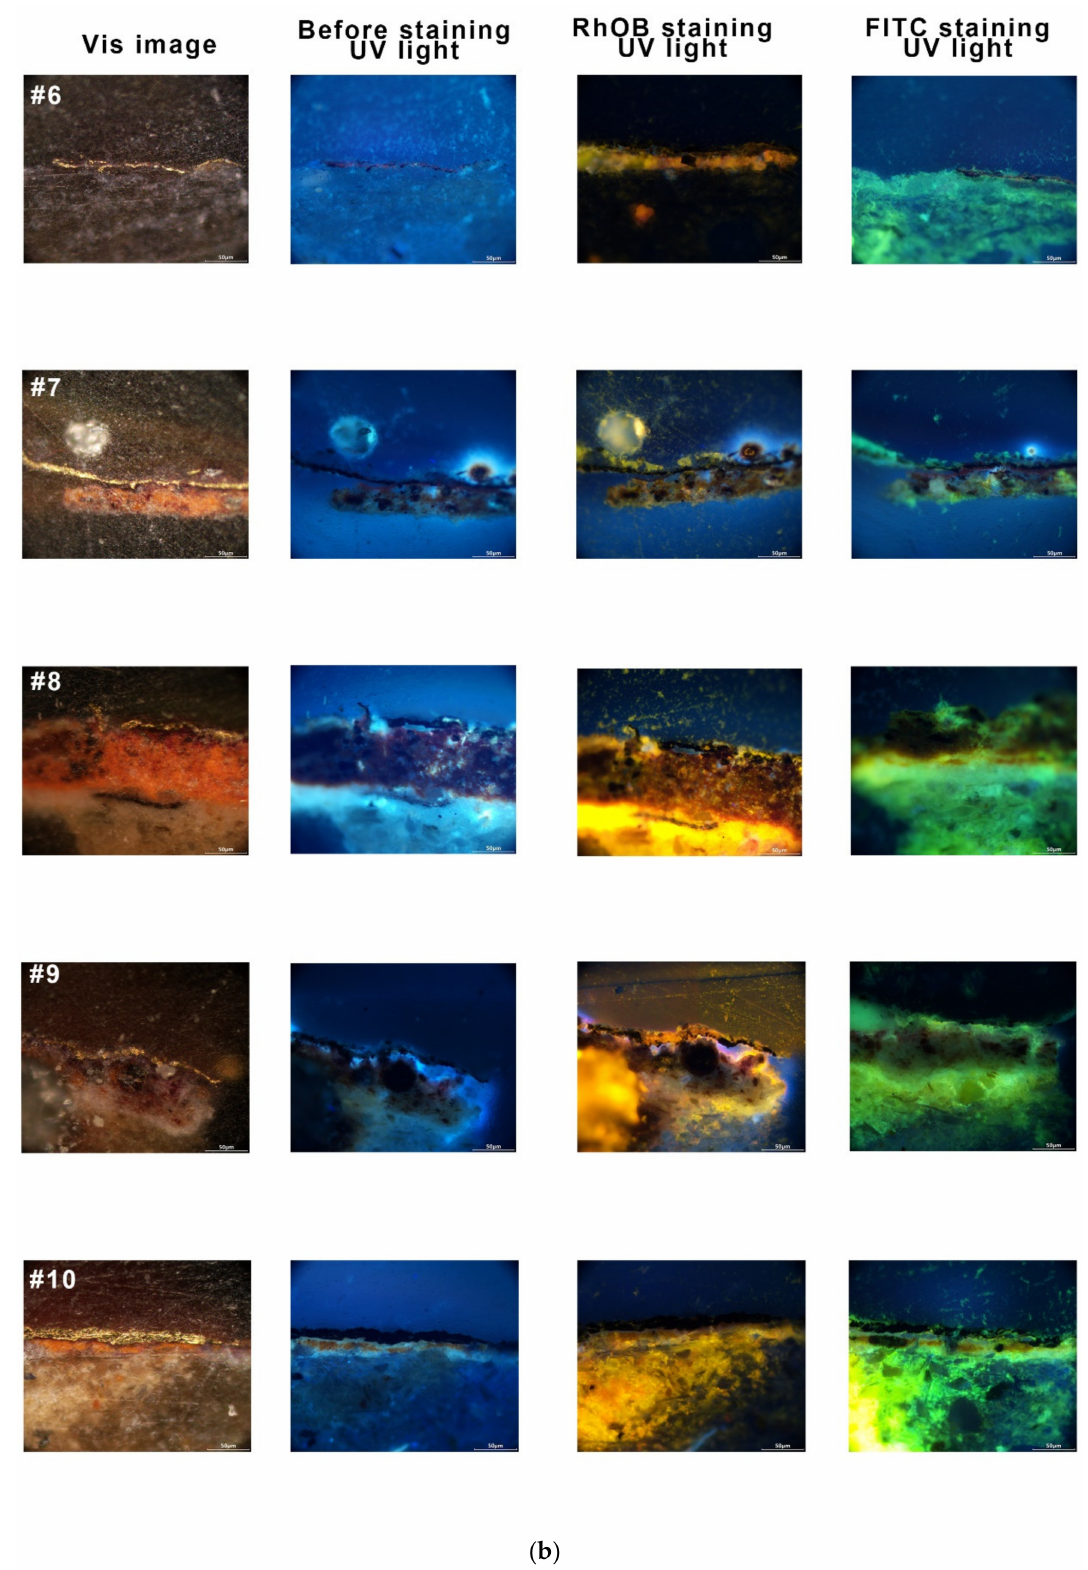
Figure A5. ( a ) Visible-light image before staining, UV light image before staining, orange light emission image after RhOB staining, and green light emission image after FITC staining of samples #1–#5. ( b ) Visible-light image before staining, UV light image before staining, orange light emission image after RhOB staining, and green light emission image after FITC staining of samples